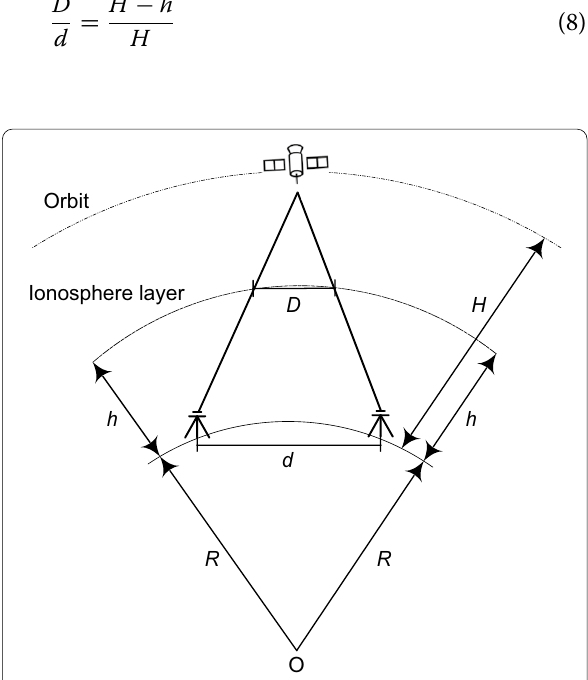
Fig. 3 Geometric relationship between the ground motion points and